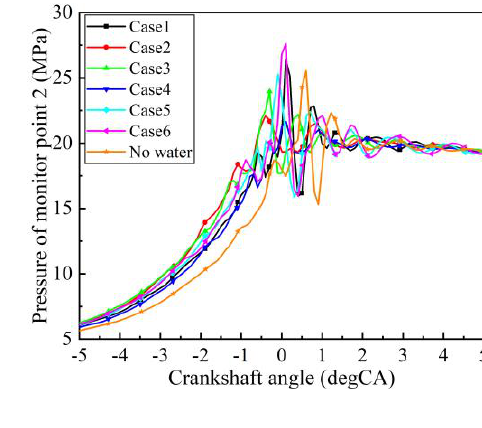
Figure 12. ( a ) Average pressure, ( b ) average temperature, ( c ) ignition delay and combustion phase in different water injection cases (CR = 10.3, ignition time = − 14 degCA).